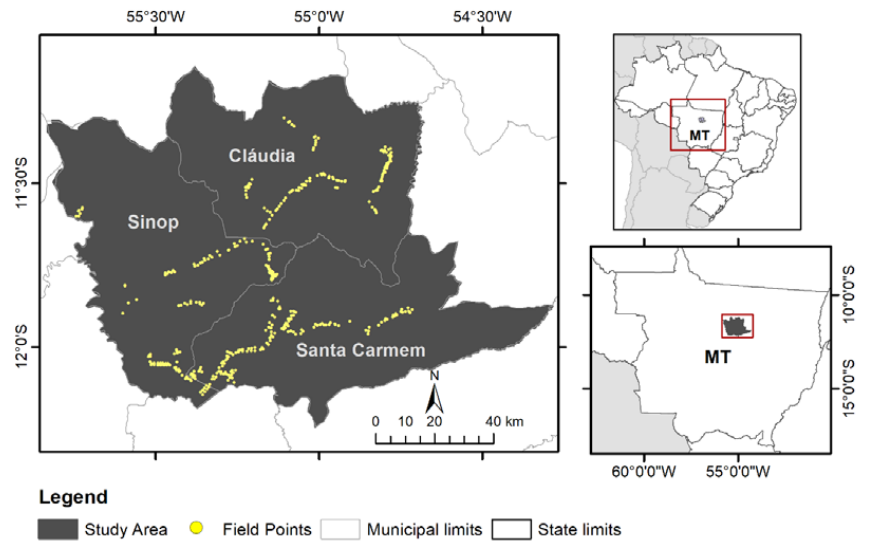
Figure 1. Study area: Sinop, Cláudia, and Santa Carmém municipalities in Northern Mato Grosso, Brazil.